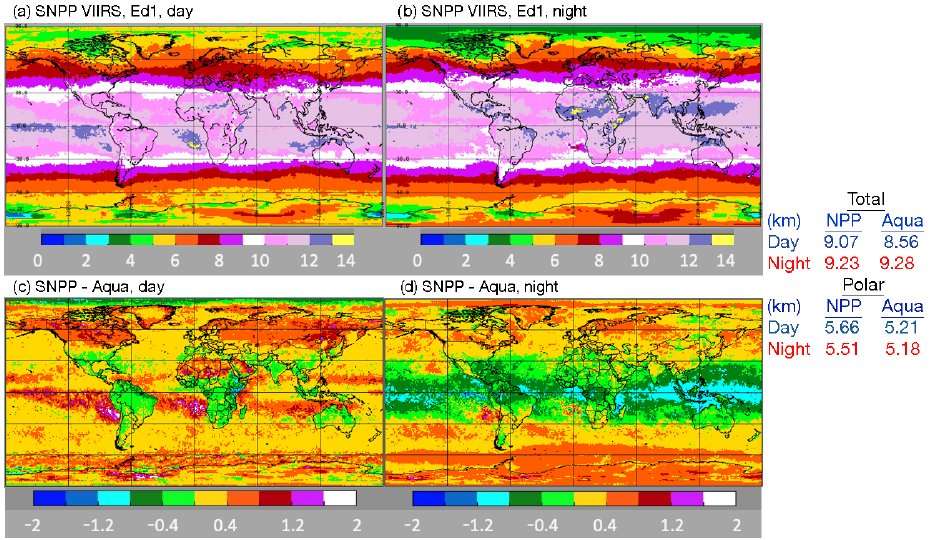
Figure 8. Mean 2013 ice cloud effective heights from CV1S during ( a ) day and ( b ) night, and the CV1S minus CM4A differences for ( c ) day and ( d ) night.